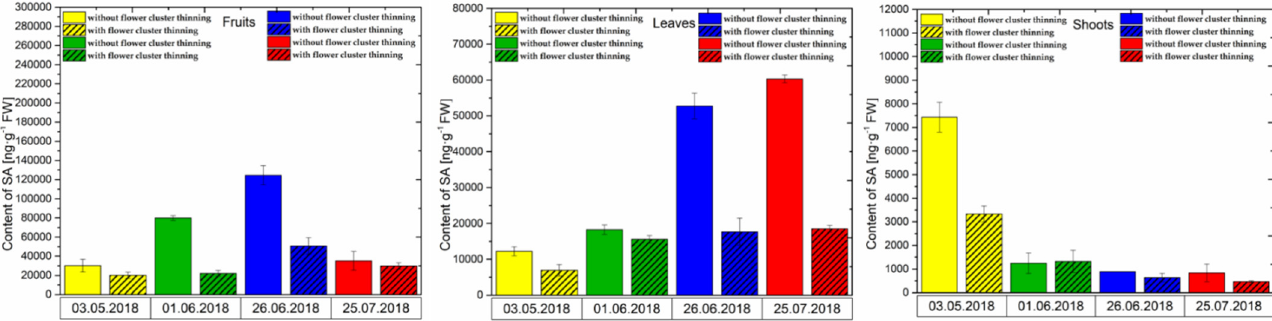
Figure 6. Concentration of SA in Organs of Pistachio Trees With or Without Flower Cluster Thinning Application.